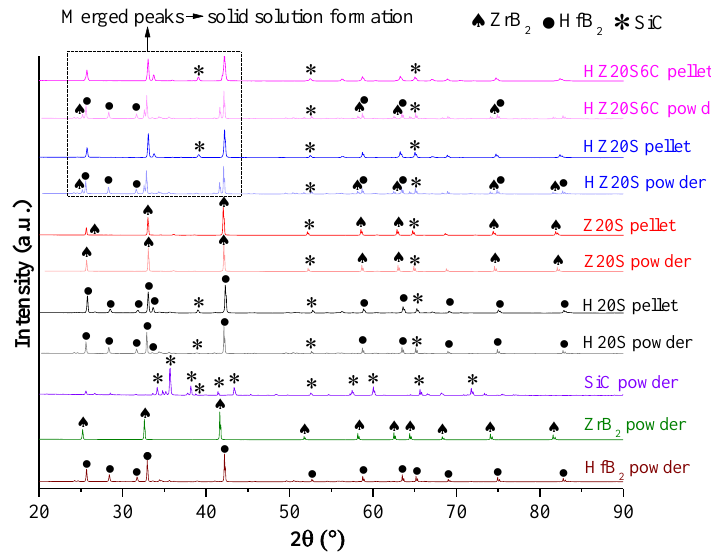
Figure 3. XRD spectra of initial composite powders as well as SPS processed HfB 2 -ZrB 2 -SiC-CNT composites.